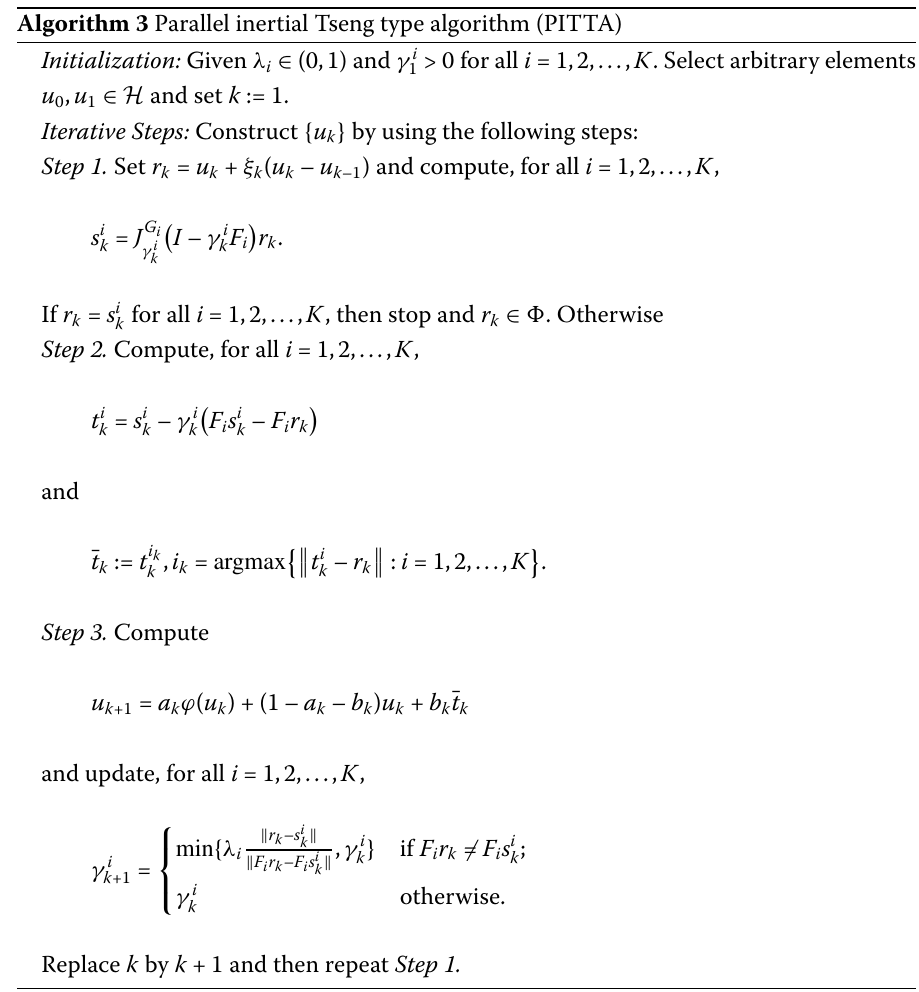
Algorithm 3 Parallel inertial Tseng type algorithm